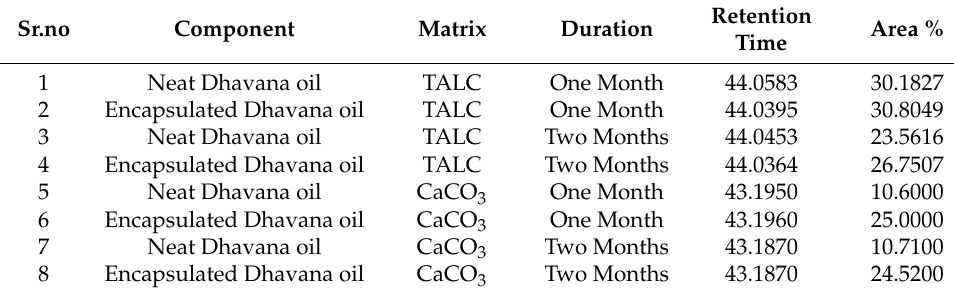
Table 6. Consolidated GCMS profile of neat and encapsulated Dhavana oil. Sr.no